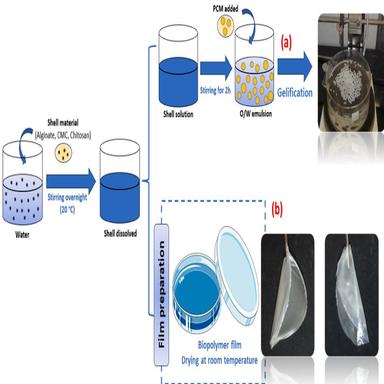
Schematic illustration of the synthesis of (a) PCM capsules and (b) biopolymer films.